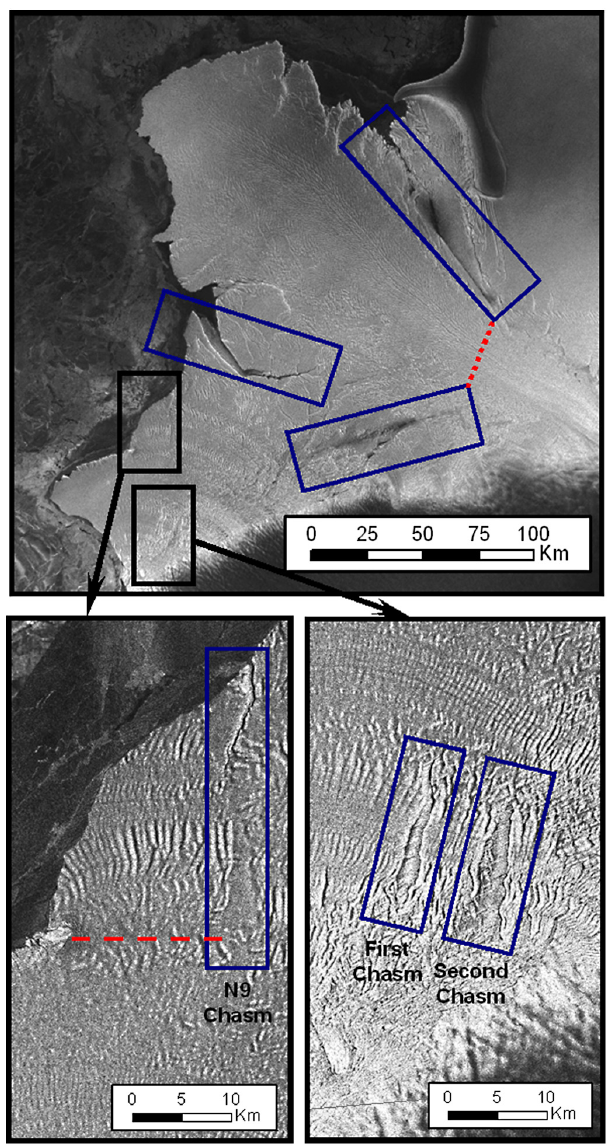
Fig. 11. Major rifts in the BIS–SWGT region. There are three large rifts in the SWGT region (discussed in Sect. 5), and three smaller dormant rifts in the BIS region, highlighted in the lower images. The dotted line in the top figure shows the shortest distance to connect two of the active rifts. The N9 Chasm, pictured lower left, may form the eastern boundary of a mini-calving event in the next decade, should weaknesses also form along the indicated dashed